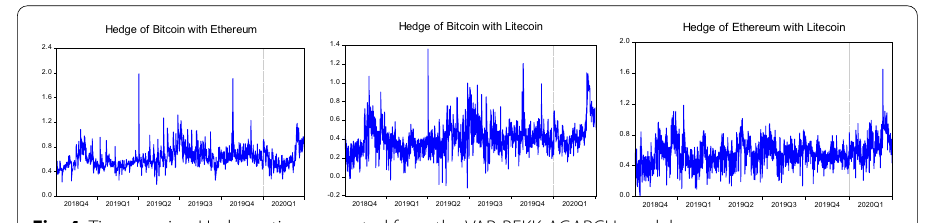
Fig. 4 Time-varying Hedge ratios computed from the VAR-BEKK-AGARCH